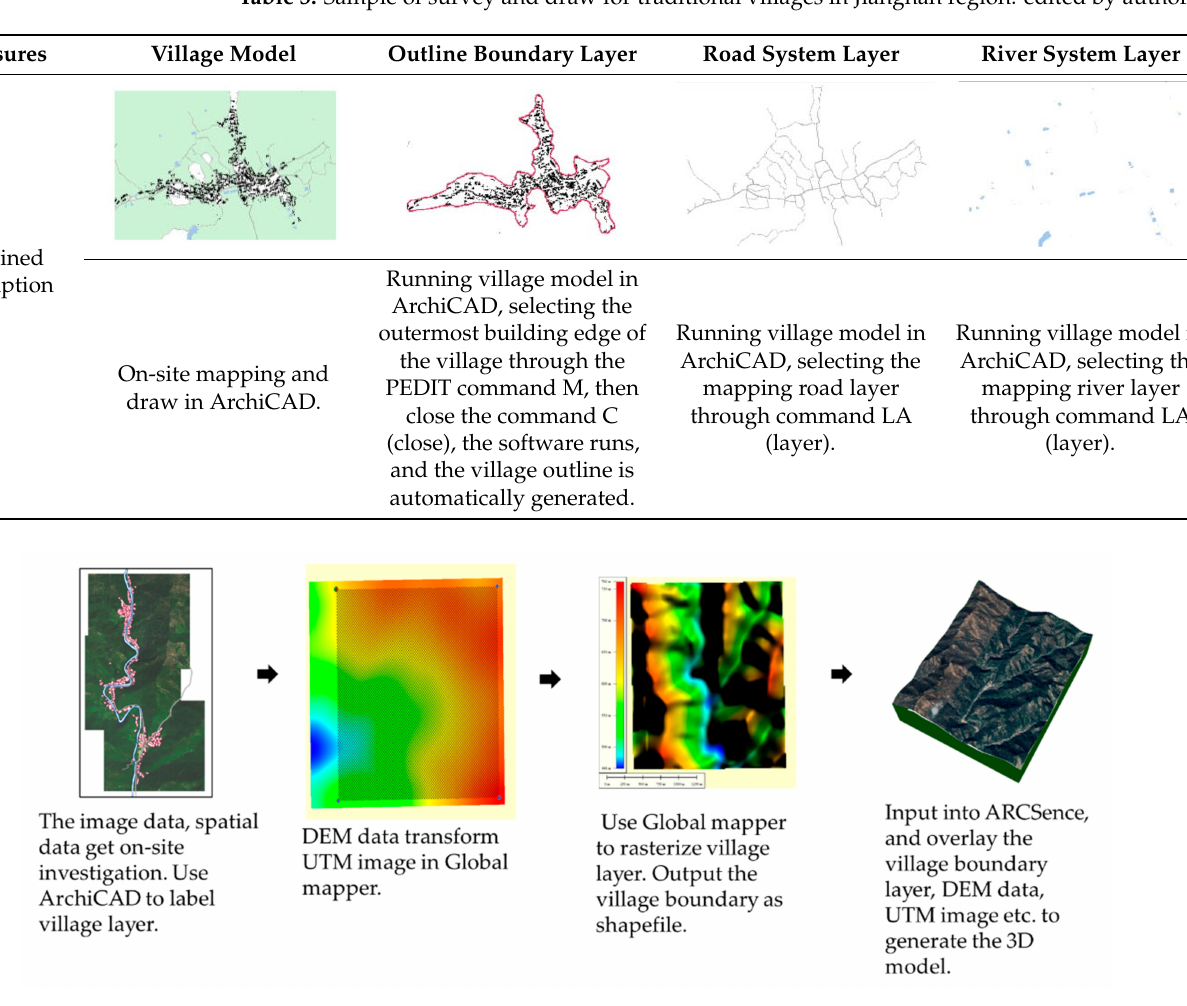
Table 3. Sample of survey and draw for traditional villages in Jiangnan region: edited by authors. Measures